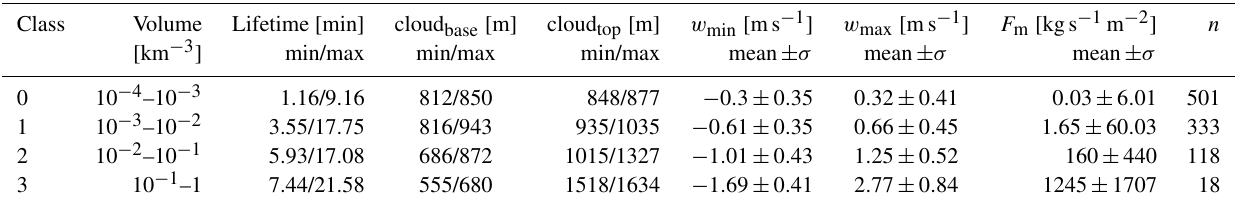
Figure 3. Rosette pattern for different times (and the number of transect associated) of exploration; adapted from Verdu et al. (2019). Green lines represent the RPA trajectories, red points the calculated geometric center at different times of exploration, and the purple point the last geometric center. Table 1. Min, max, mean, and standard deviation of macroscopic and dynamic characteristics of the 970 clouds that complete a full life cycle during